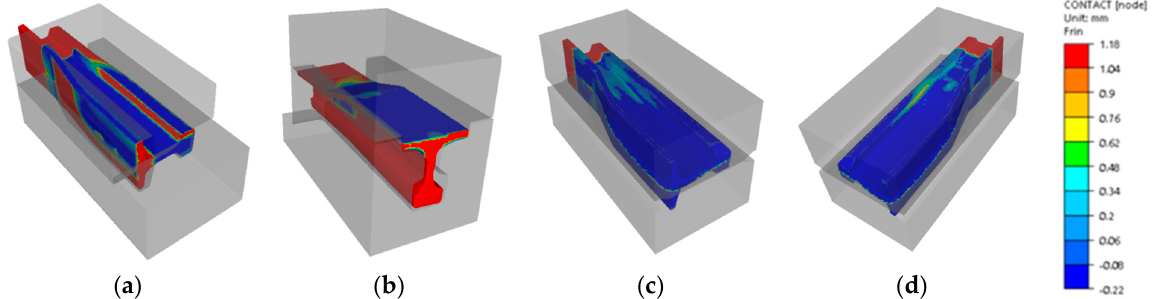
Figure 15. Contact distribution after: ( a ) operation I, ( b ) operation II, ( c ) operation III (top view), ( d ) operation III (bottom view); the contact area is marked in dark blue.